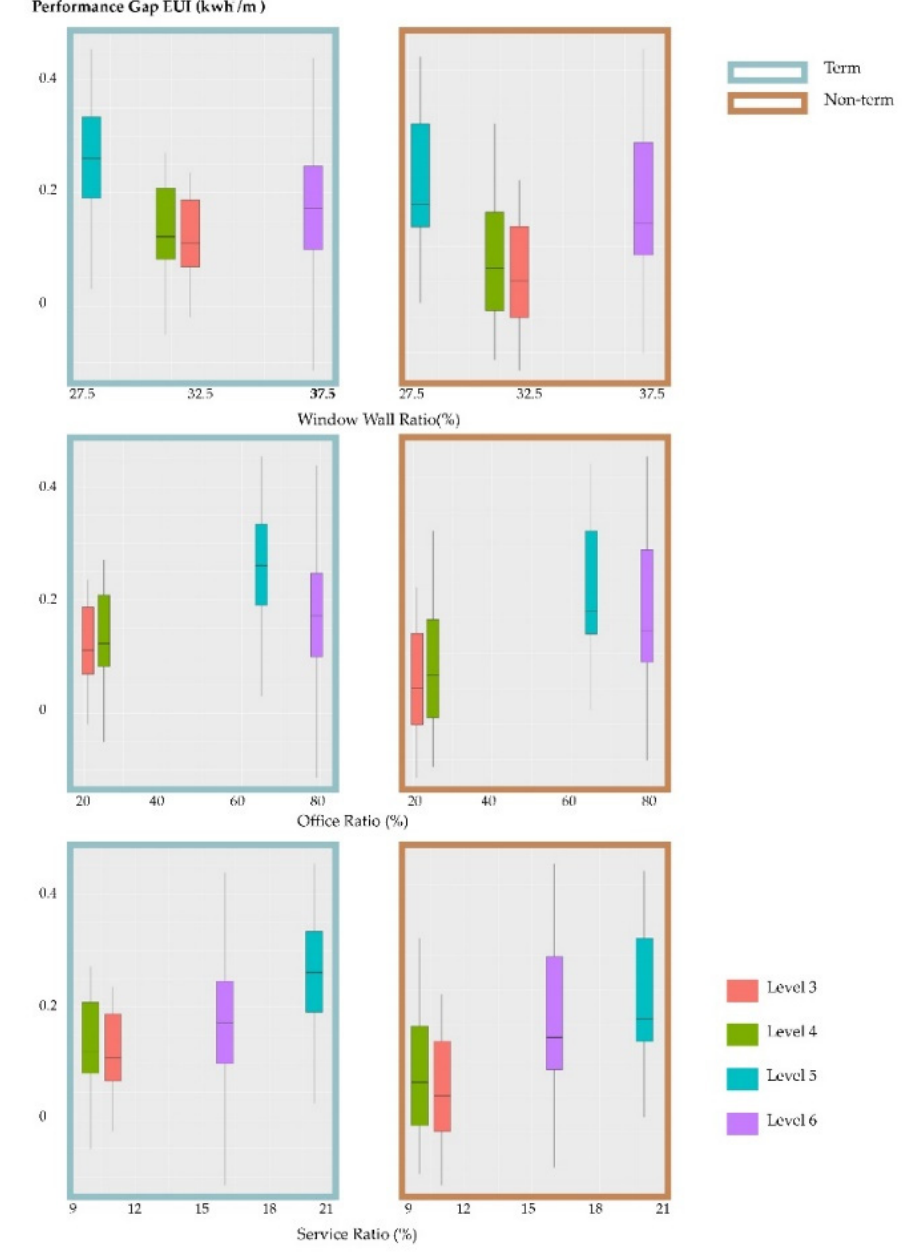
Figure 9. Building characters and energy performance gap.